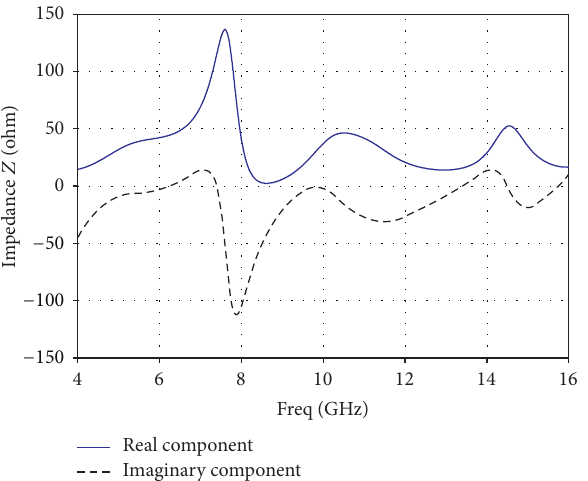
Figure 8: Impedance 𝑍 ( Ω ) versus frequency (GHz).